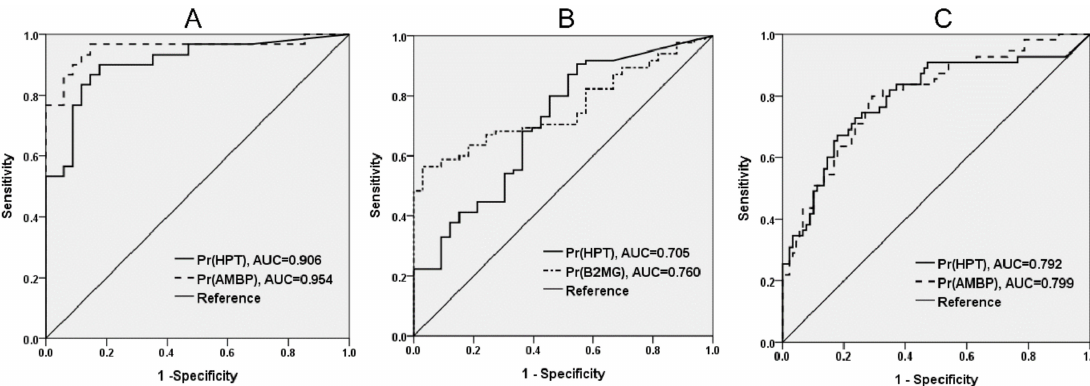
Figure 3. Receiver operating characteristic (ROC) analysis and area under the curve (AUC) of two protein biomarkers with the highest discriminative ability in the initial verification phase (case control study design). A . Healthy individuals vs. patients with micro- or macro-albuminuria due to nondiabetic disease (WDM-NP); B . Healthy individuals vs. diabetic patients without micro- or macro-albuminuria (DM-WNP); C . DM-WNP vs. diabetic patients with microalbuminuria (DM-NP).